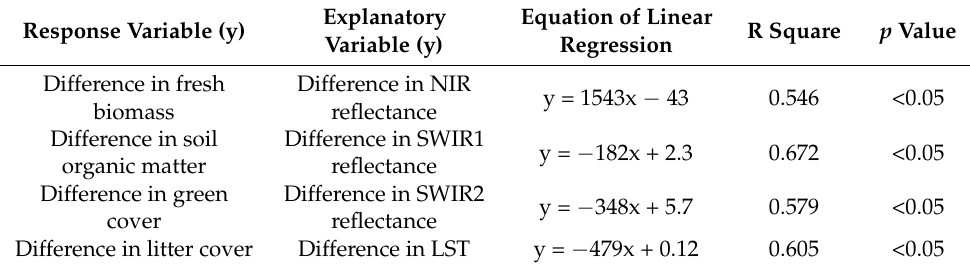
Table 2. Linear relationship between the difference in biophysical parameters and the difference in Landsat reflectance or land surface